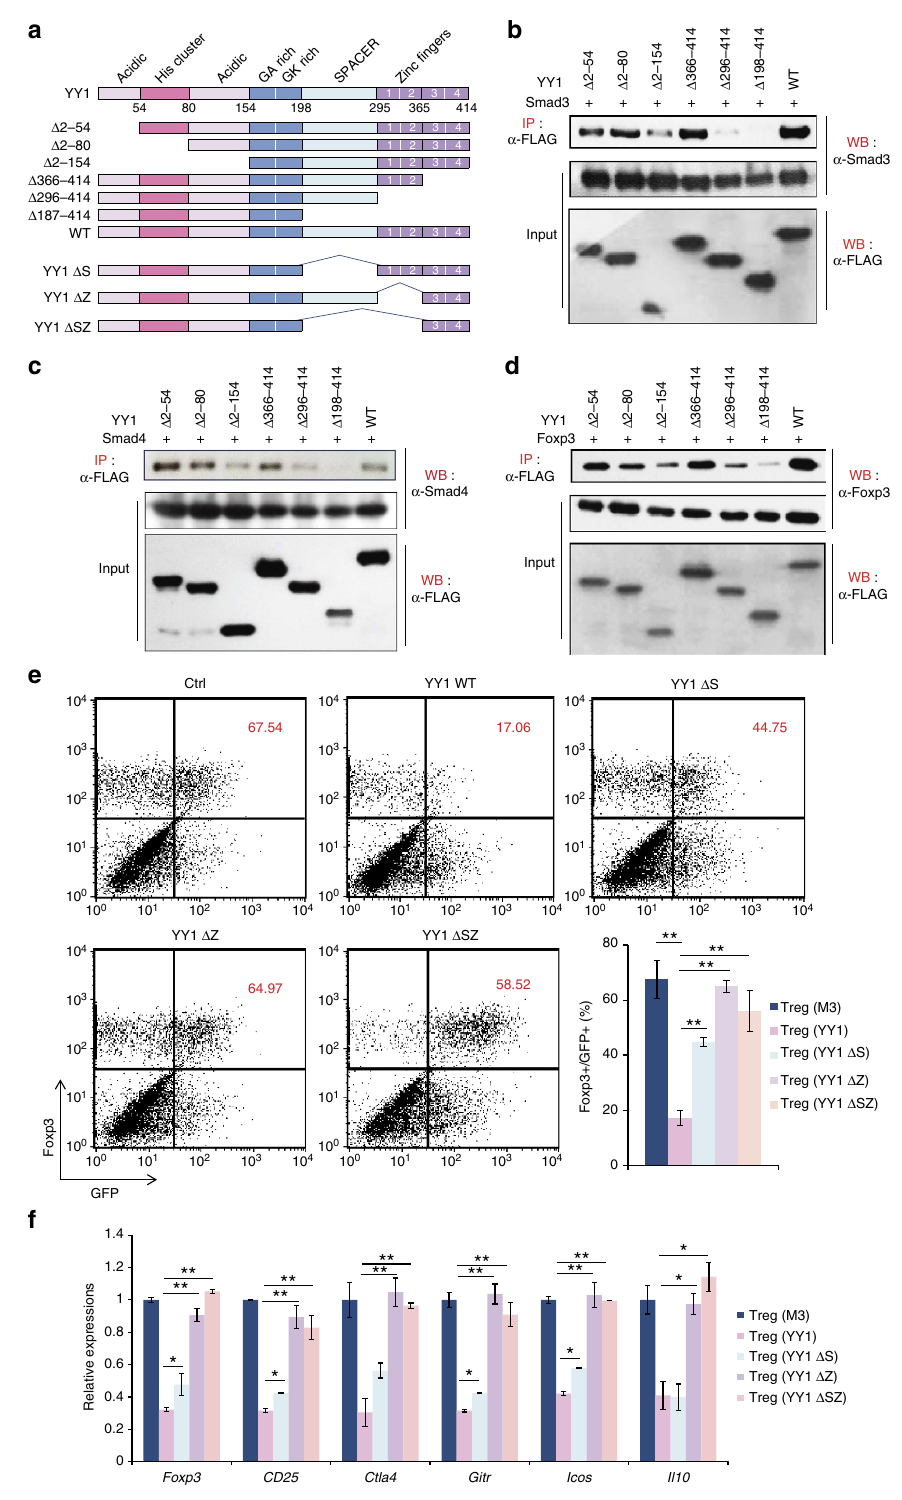
Figure 9 | Spacer and zinc finger 1-2 domains of YY1 are essential for inhibition of T reg differentiation. ( a ) Schematic diagram of YY1 domains. ( b – d ) HEK293T cells were transfected with Smad3-, Smad4- or Foxp3-expression vector together with various FLAG-tagged, YY1 domain mutant expression vectors. Cell lysates were immunoprecipitated with anti-FLAG. Then, proteins were immunoblotted by an anti-Smad3 ( b ), anti-Smad4 ( c ), anti-Foxp3 ( d ) or anti-FLAG antibody, as indicated. IP, immunoprecipitation; WB, immunoblot. ( e ) Naı¨ve CD4 T cells were transduced with a retroviral vector containing control, YY1 (full length), YY1 D S, YY1 D Z or YY1 D SZ, and differentiated into T reg cells for 4 days. Expression of Foxp3 was measured by flow cytometry. Numbers in the plots indicate percentage of Foxp3 þ cells from GFP þ cells. ( f ) GFP þ cells from e were sorted, and total RNA was isolated. Relative amounts of the Foxp3 and T reg signature genes were measured by qRT–PCR. Experiments were performed three times with similar results. Error bars shown in b and f represent s.d. Statistical differences in e and f were analysed by Student’s t -test ( n ¼ 3). * P o 0.05. ** P o 0.01.